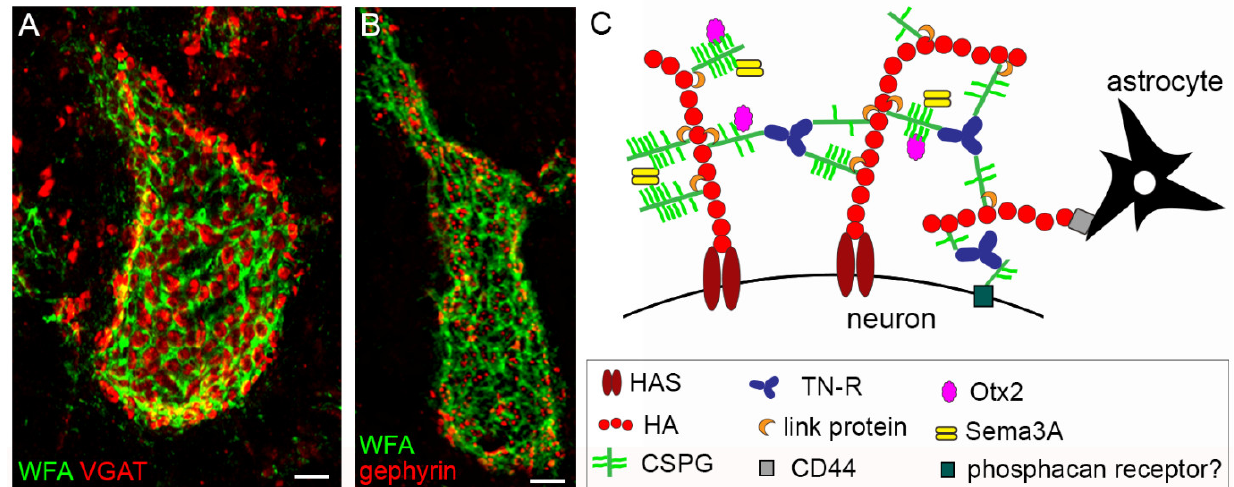
Figure 1. Structure and composition of the PNN. ( A , B ) show PNNs around neurons in the mouse cerebellar nuclei, labelled by Wisteria floribunda agglutinin (WFA), in green. PNNs display their typical holes, in which pre-synaptic terminals are contained. In ( A ), GABAergic terminals are shown (in red), labelled by anti-VGAT antibodies. In ( B ), post-synaptic clusters of gephyrin, which anchors GABA receptors to the underlying cytoskeleton, are shown (in red). In ( C ), the main molecular components of PNNs are depicted. Scale bar: 4 µm in ( A , B ). Image reproduced from Carulli and Verhaagen, with permission of MDPI, Int. J. Mol. Sci .